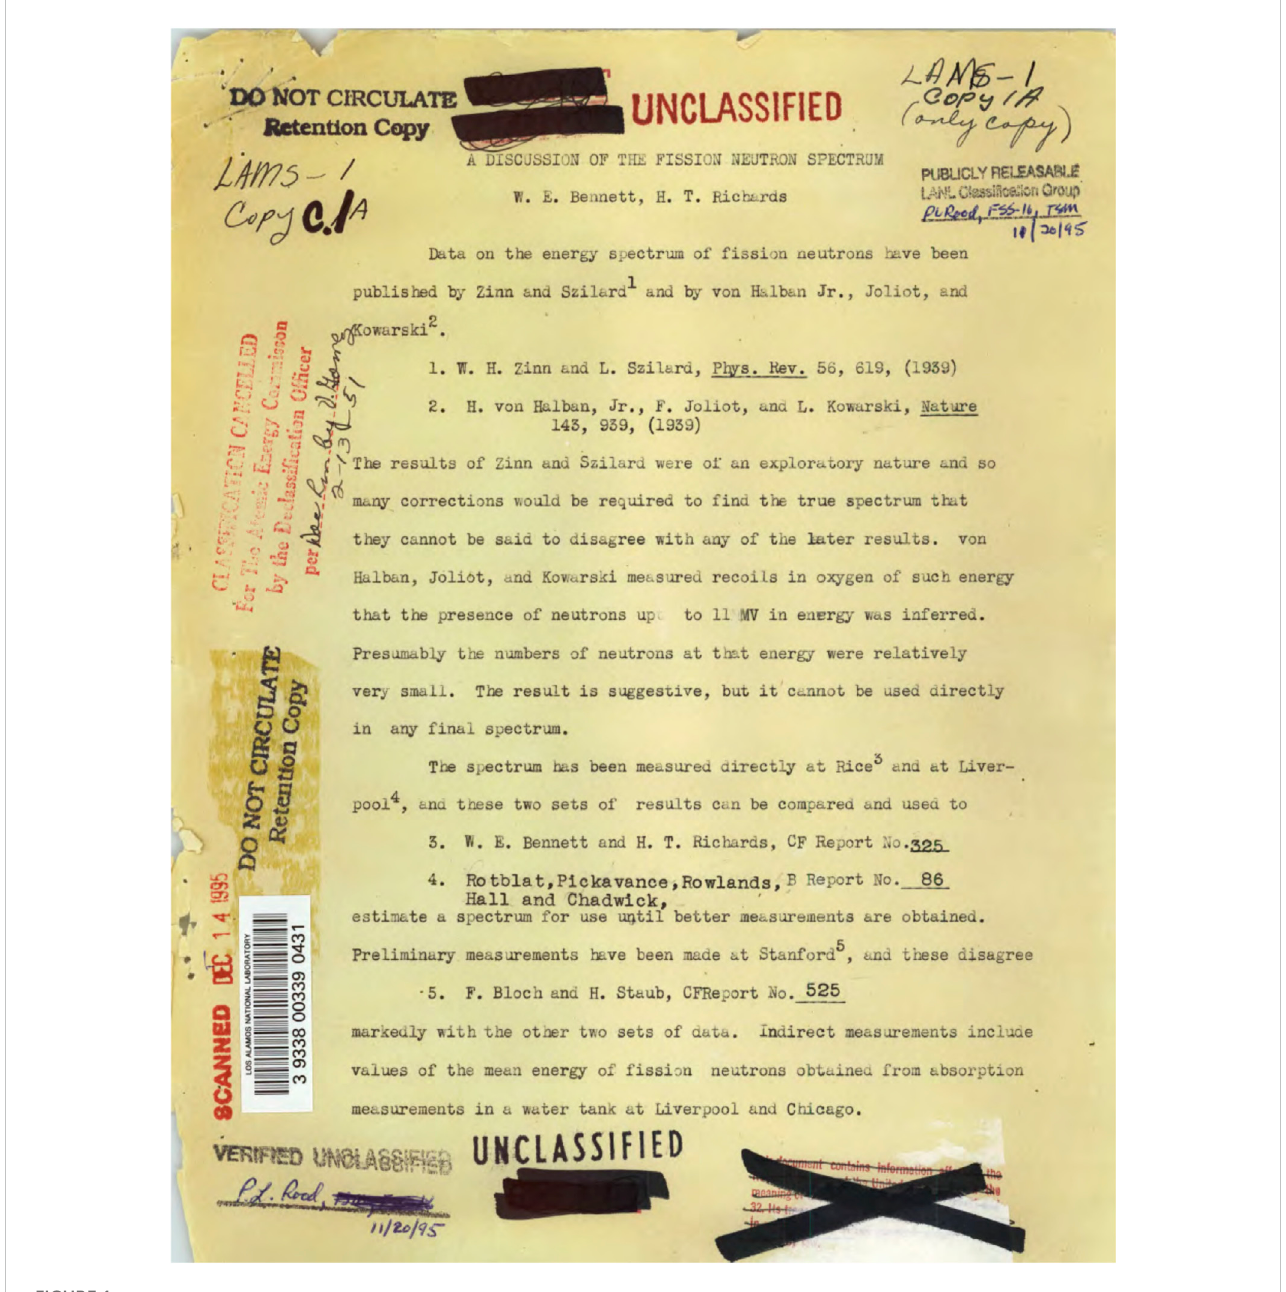
An image extract from the fi rst page of theApril1943 Los Alamosdocument LAMS-1 [5]. Although thiswas published atLos Alamoswhen the Manhattan Project scientists arrived in 1943, Bennett and Richard ’ s measurement was made at Rice